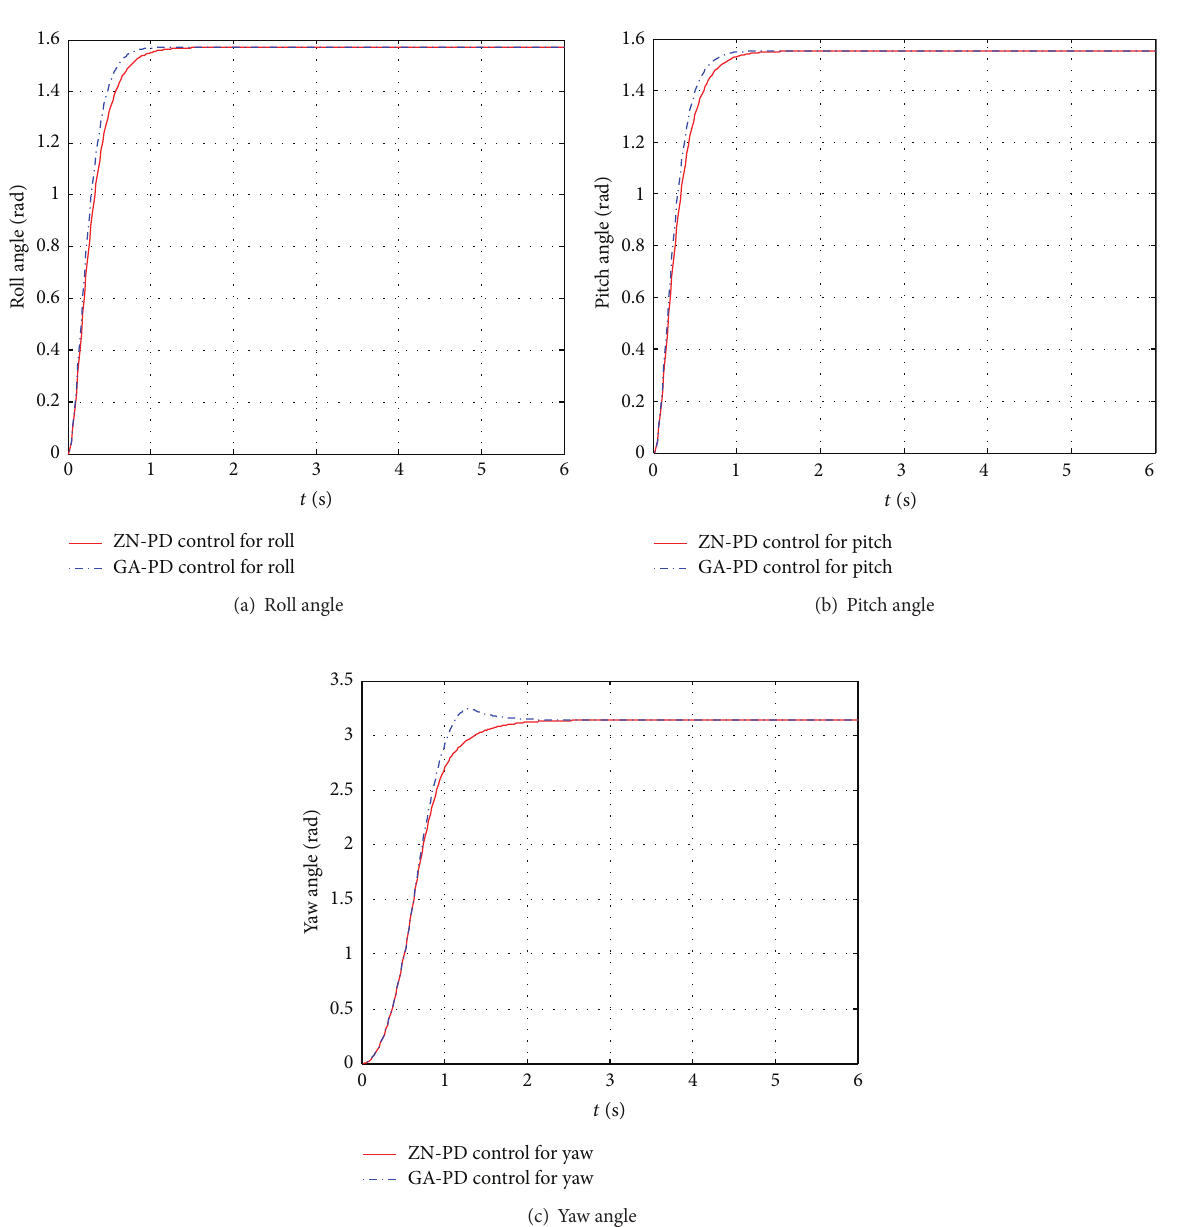
Figure 6: The control effects compare diagrams between ZN-PD and GA-PD of separately controlling an attitude angle to the desired angle, while the rest attitude angles remain 0. (a) The control effects compare diagram of the roll angle. (b) The control effects compare diagram of the pitch angle. (c) The control effects compare diagram of the yaw